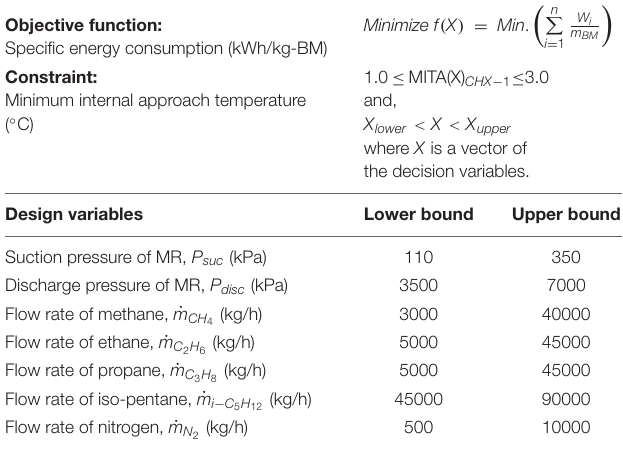
TABLE 2 | Key decision variables of the SMR process and their upper and lower bounds. Objective function: Specific energy consumption